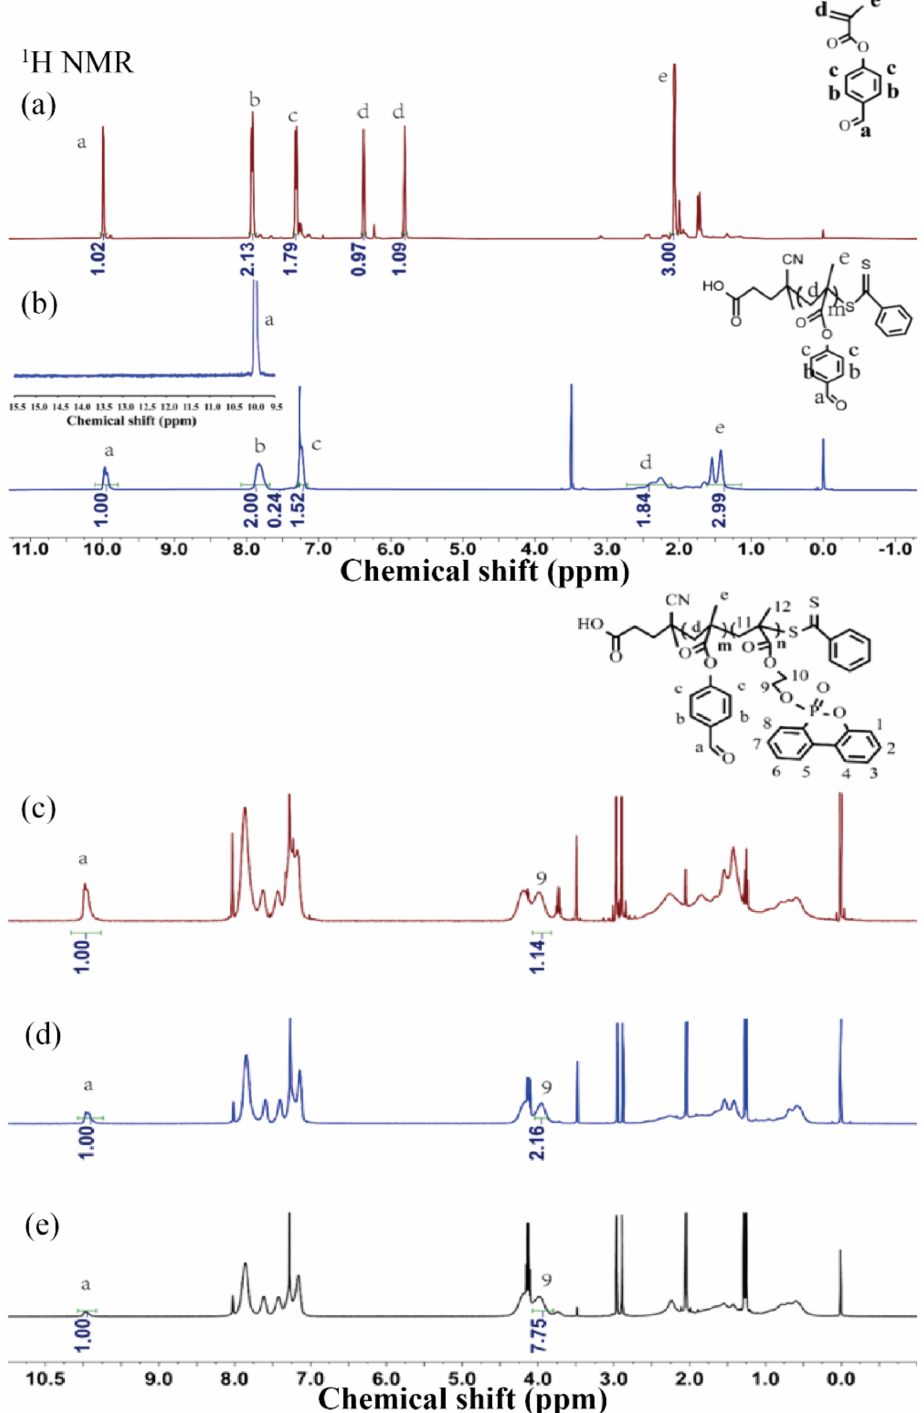
Figure 2. The 1 H NMR spectra of ( a ) HAMA, ( b ) HAMA-CTA, ( c – e ) poly(HAMA m -b-HEPOMA n